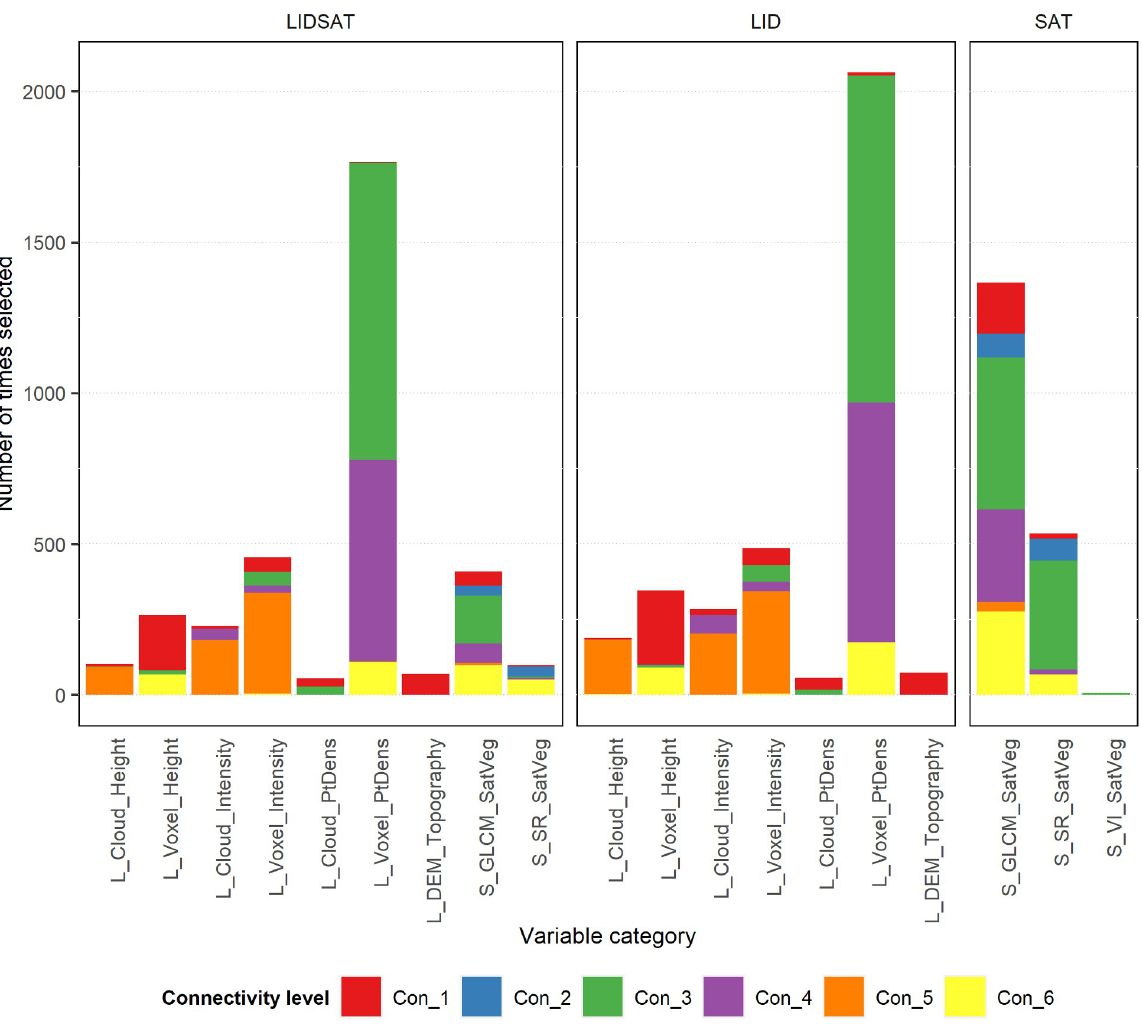
Fig 4. Bar chart of the number of times variables in each category were selected by the 100 iterations of the Boruta algorithm for the LIDSAT, LID, and SAT